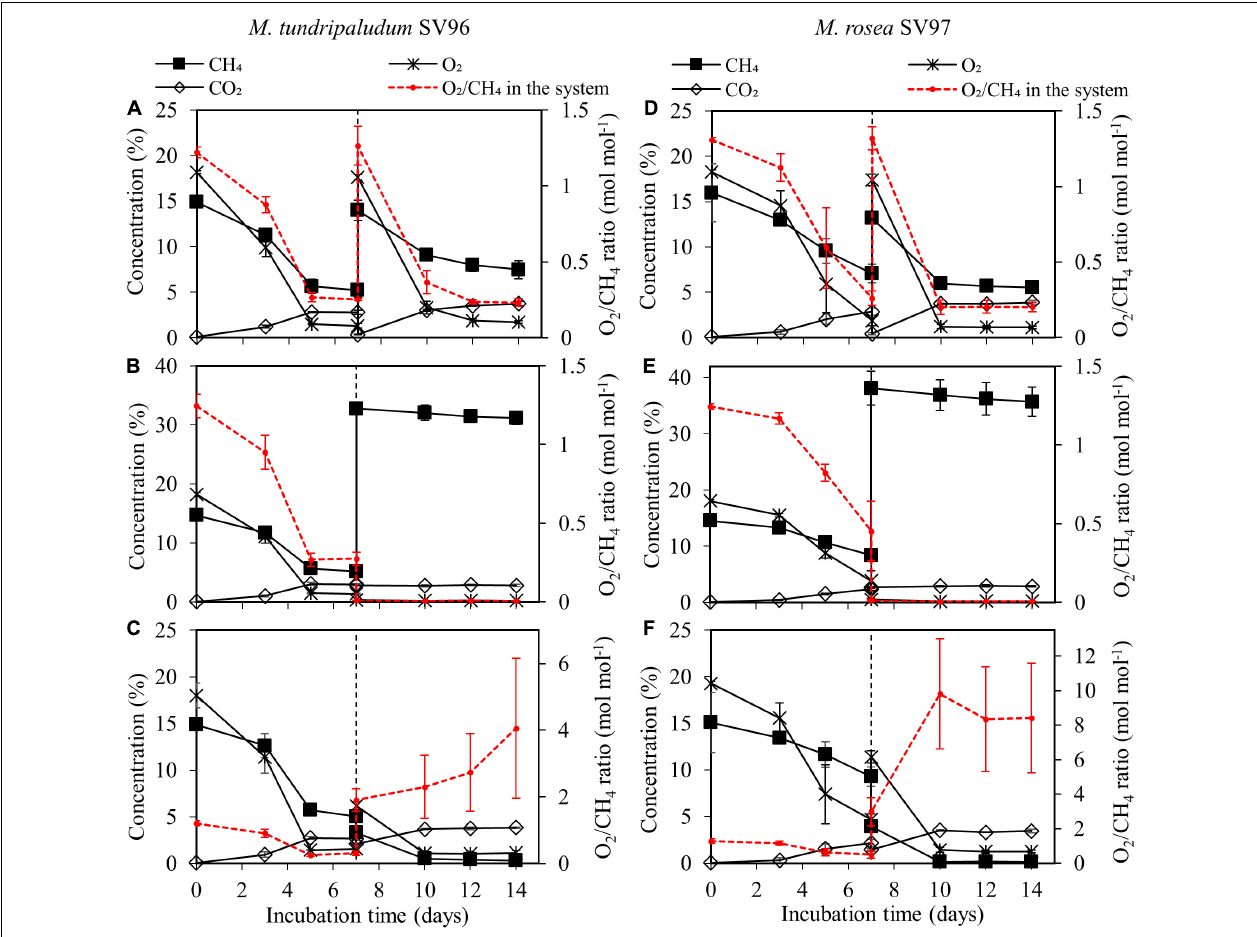
FIGURE 4 | Gas compositions (CH 4 , O 2 , and CO 2 ) in headspace during the 14-day incubation of M. tundripaludum SV96 (left column) and M. rosea SV97 (right column) under three different gas supplementation schemes applied on day 7: (test I) both CH 4 and air added (A,D) , (test II) only CH 4 added (B,E) , and (test III) only air added (C,F) . Error bars indicate the standard deviation of triplicate